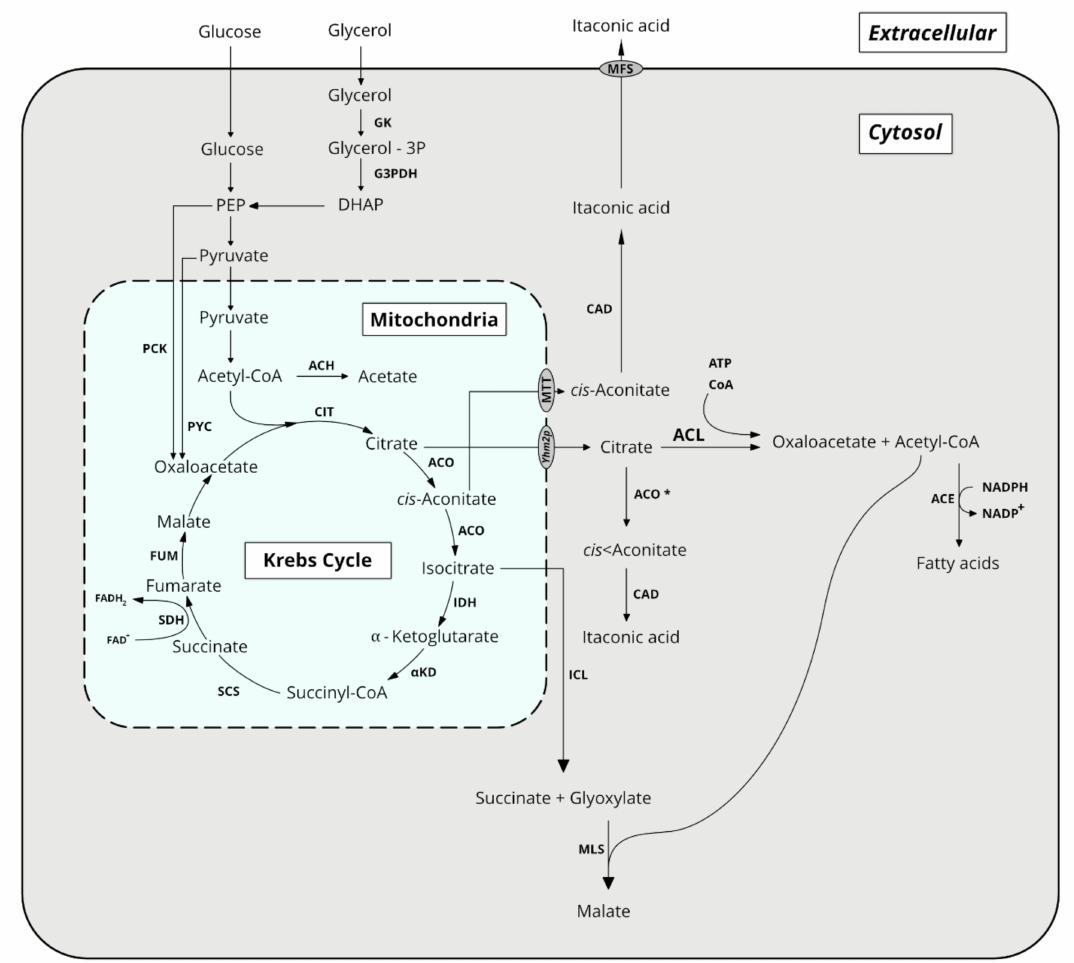
Figure 1. Overview of the principal metabolic pathways for organic acid synthesis in Y. lipolytica